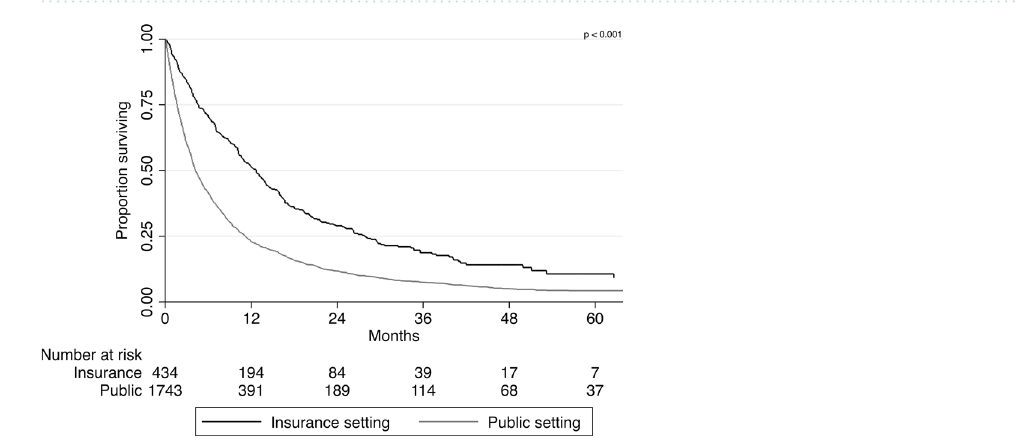
Figure 2. Overall survival in the 2010–2014 period according to source of payment (insurance or